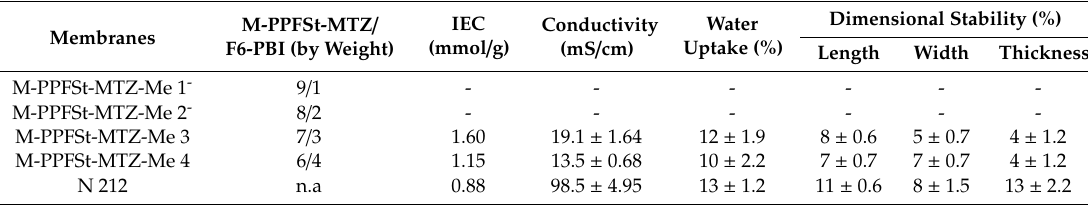
Table 1. The properties of blend membranes and